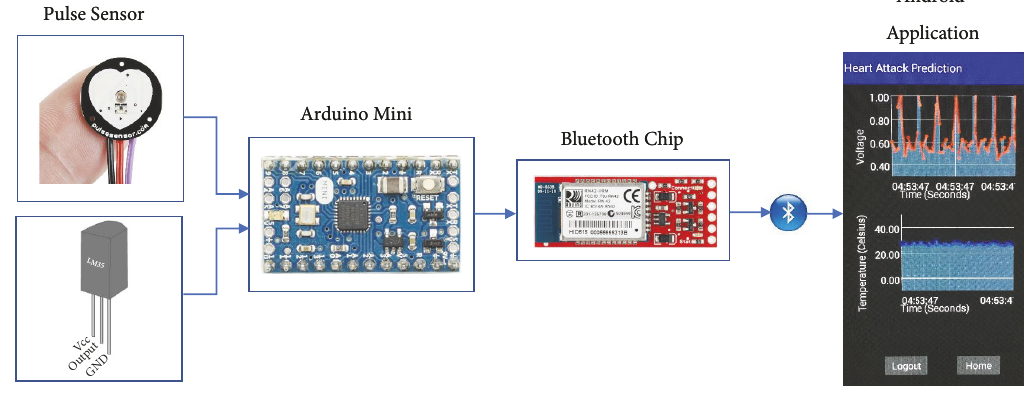
Figure 7: Data collection interface.